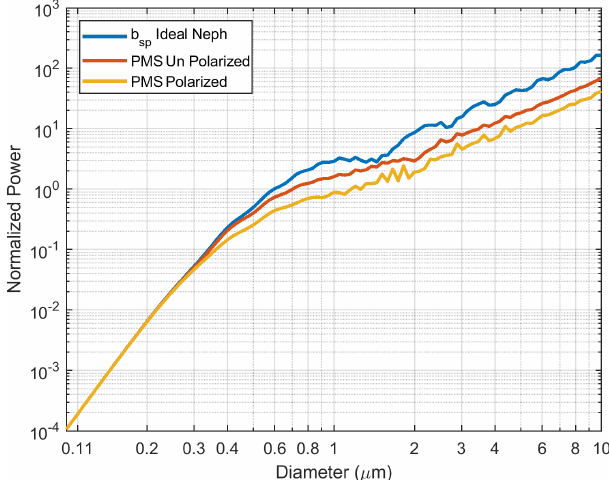
Figure 5. Relative intensity of radiant energy scattered by a log- normally distributed aerosol volume size distribution with a volume mean diameter of 0.33µm and geometric standard deviation of 1.7 as a function of location of scattering event in the laser and as a function of position on the photodiode. Assumed laser wavelength was 650nm, and the particle index of refraction was assumed to be 1.53. Positions in the laser and detector are from left to right as in Fig. 1 and are in units of millimeters.